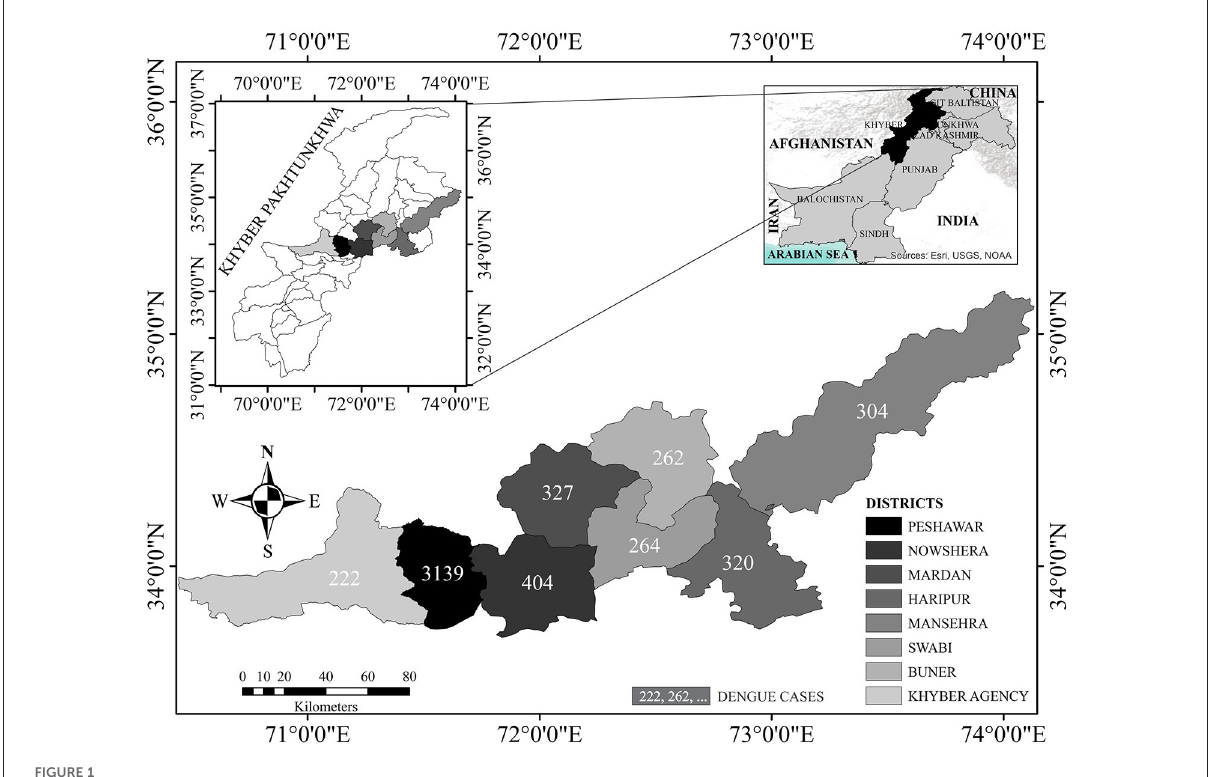
FIGURE1 Map of Khyber Pakhtunkhwa